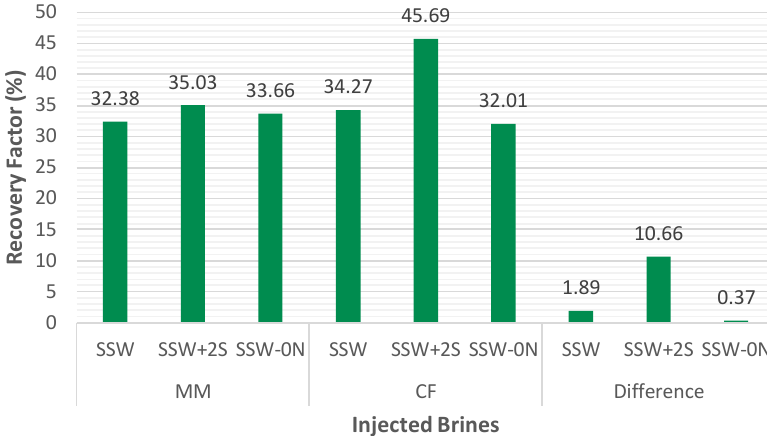
Figure 23. Comparison between oil-wet artificial structure micromodel and oil-wet Bentheimer core plugs recovery factors after brine flood in secondary mode.